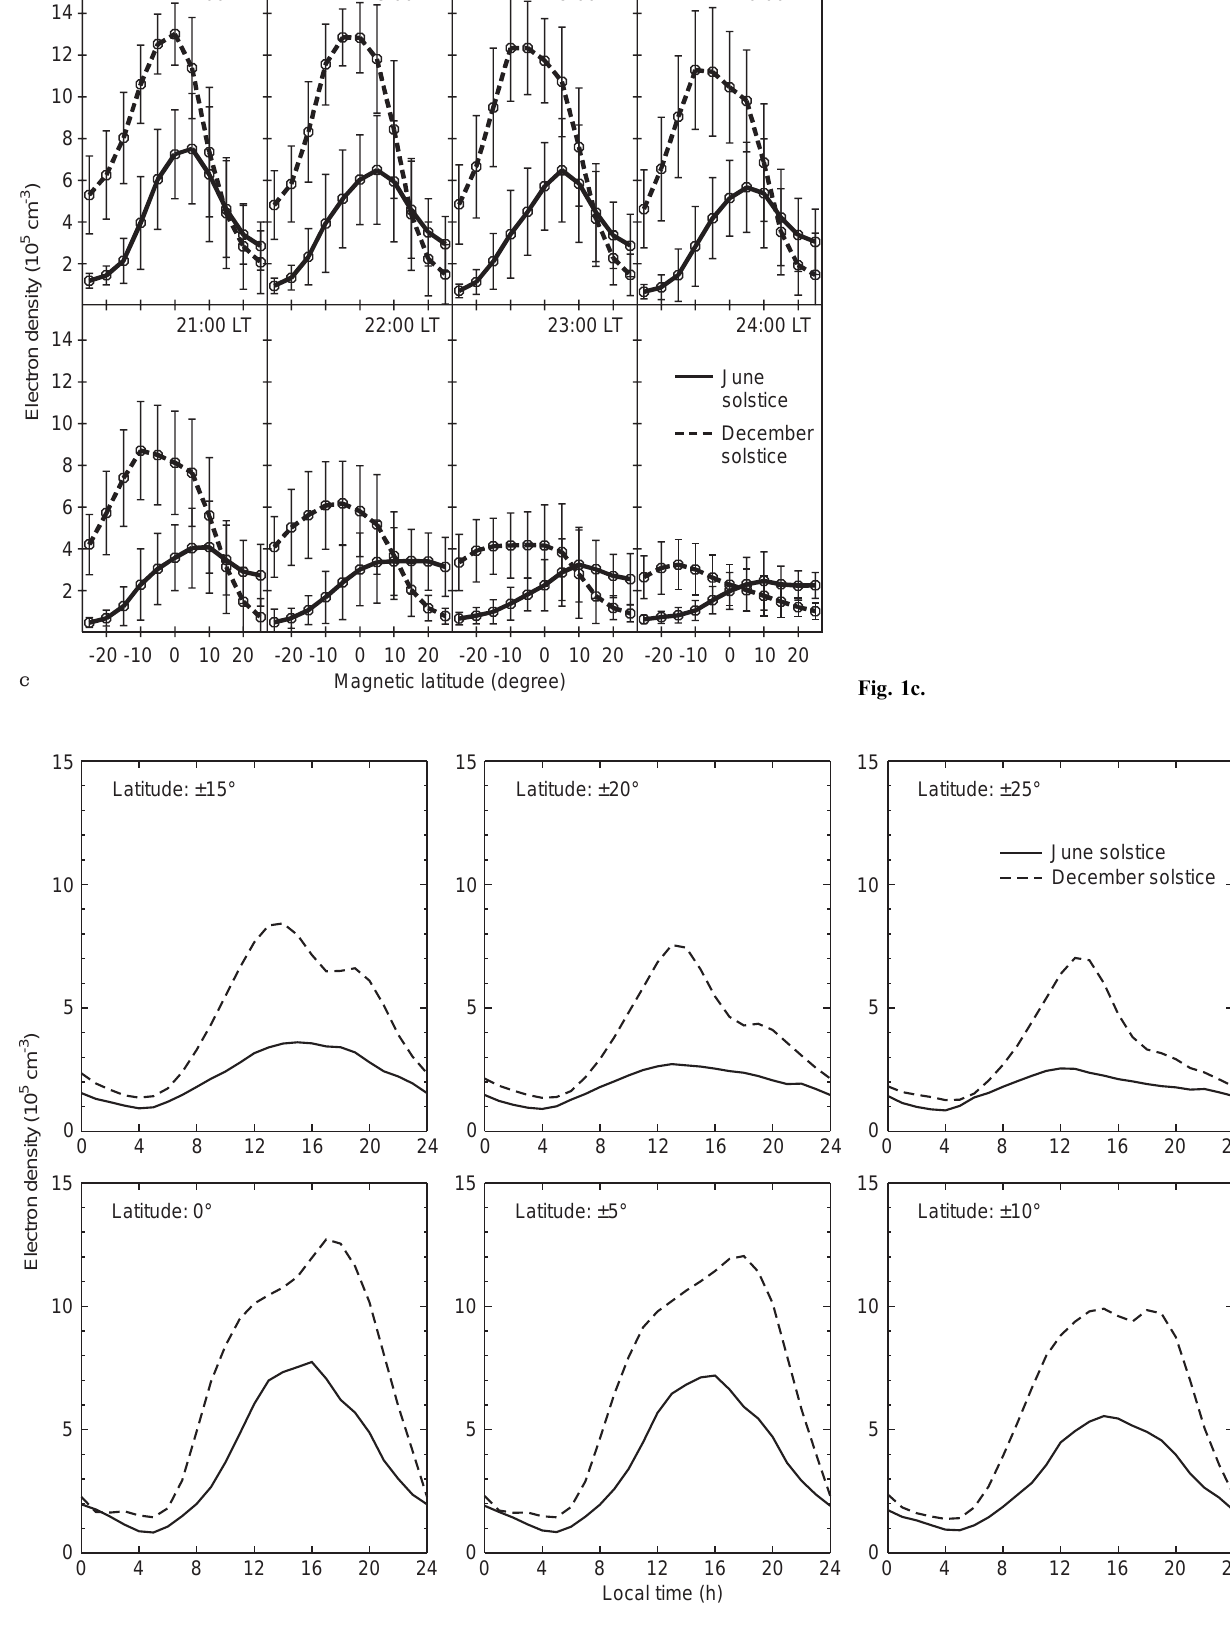
Fig. 2. Diurnal variations of the observed electron density at latitude 0 (cid:14) , and the averages of the observed electron densities at latitudes (cid:6) 5 (cid:14) , (cid:6) 10 (cid:14) , (cid:6) 15 (cid:14) , (cid:6) 20 (cid:14) and (cid:6) 25 (cid:14) , for June solstice ( solid curves ) and December solstice ( dashed curves